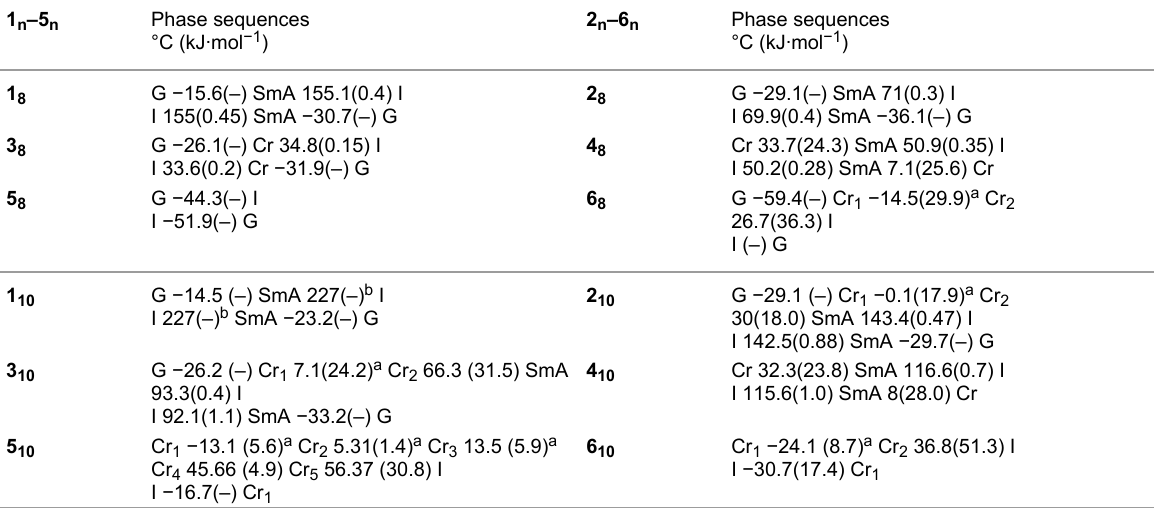
Table 1: Temperatures and enthalpy changes of the phase transitions for 1 8–10 to 6 8–10 . G: Glass; Cr: solid; SmA: Smectic A phase; I: isotropic liquid; Dec: decomposition. 1 n –5 n